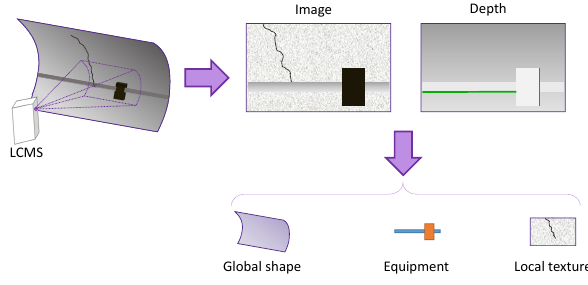
Figure 1. Outline of the approach